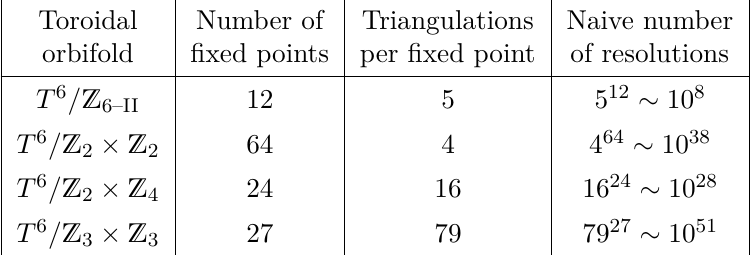
Table 11 . Triangulation dependence and the naive number of resulting resolutions of toroidal orbifolds as can be inferred from the data in ref.